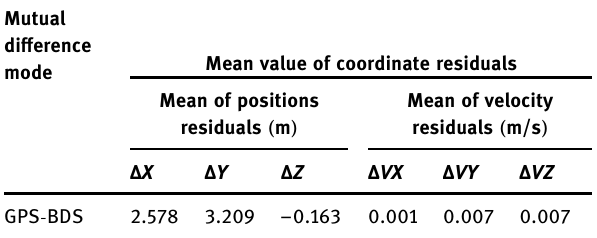
Figure 7: Velocity precision of on - board BDS and GPS in X - direction.